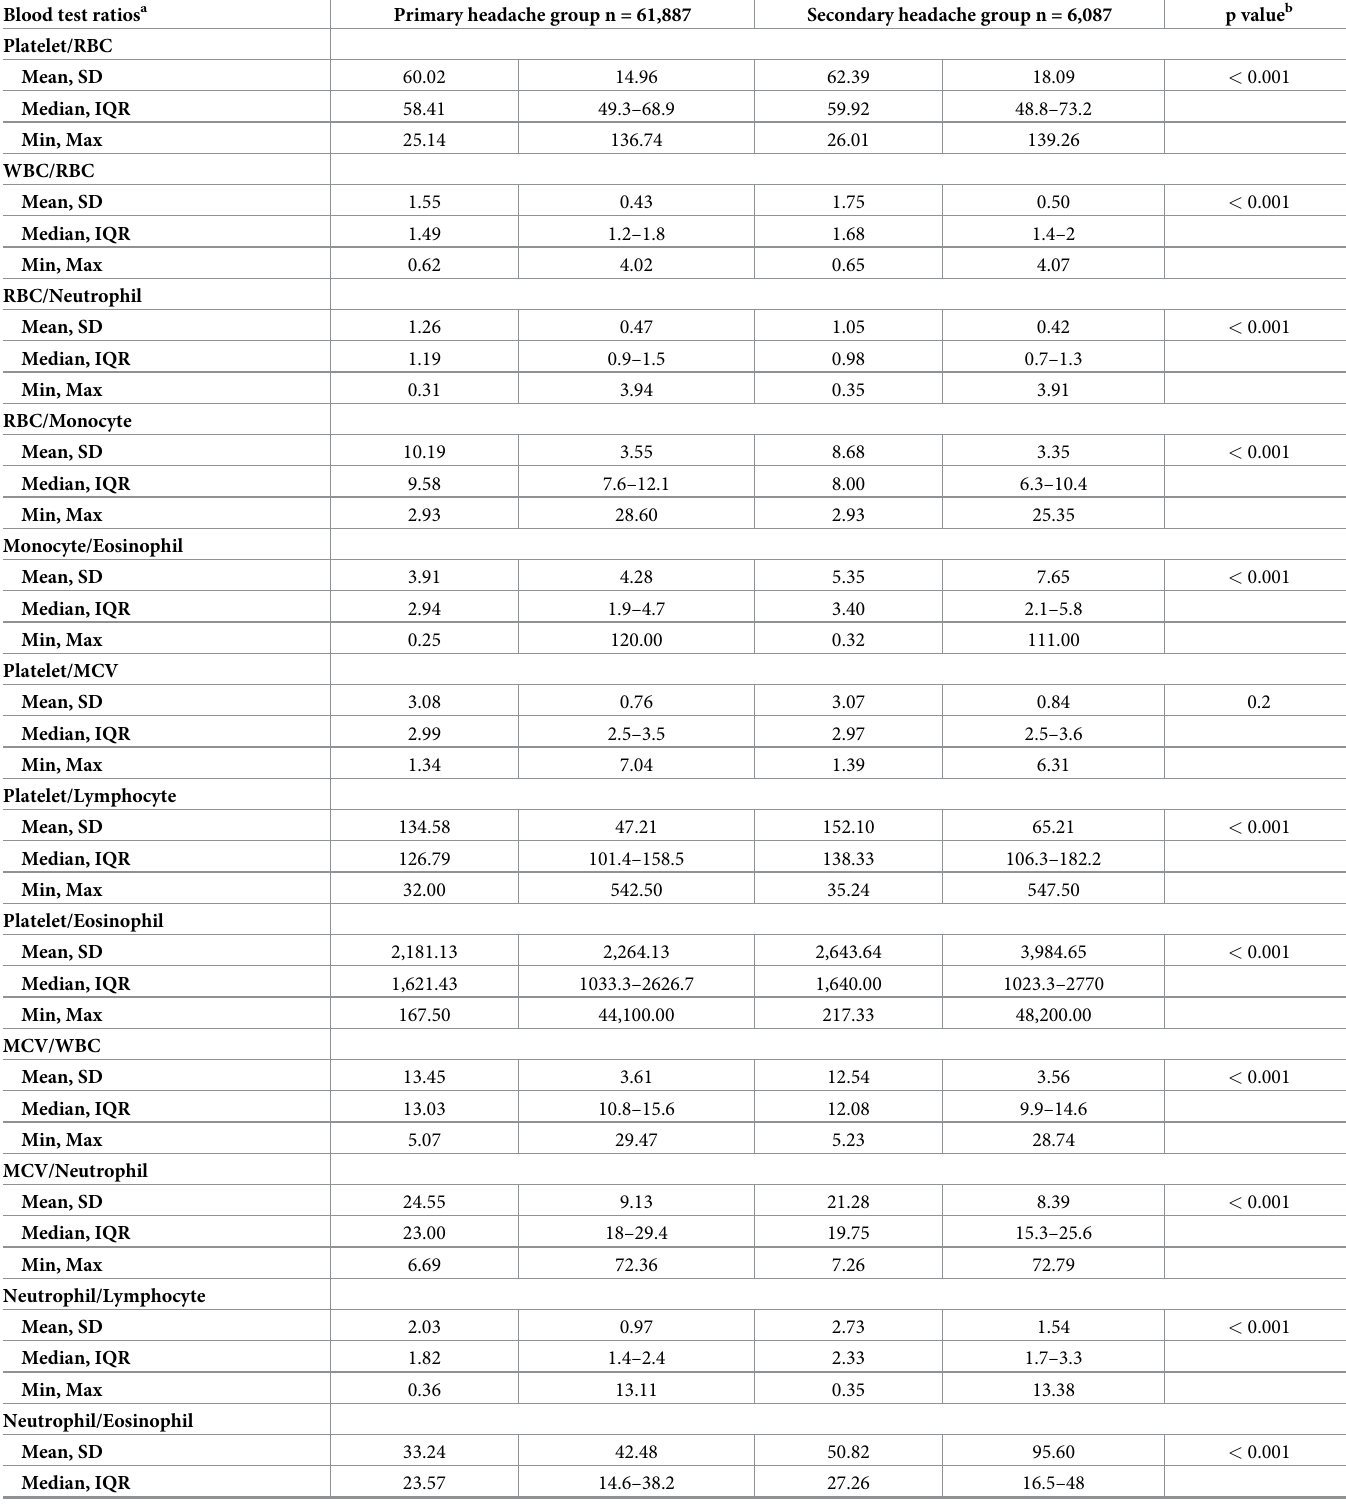
Table 3. Descriptive statistics for blood cell ratios for the analytical cohort (n =